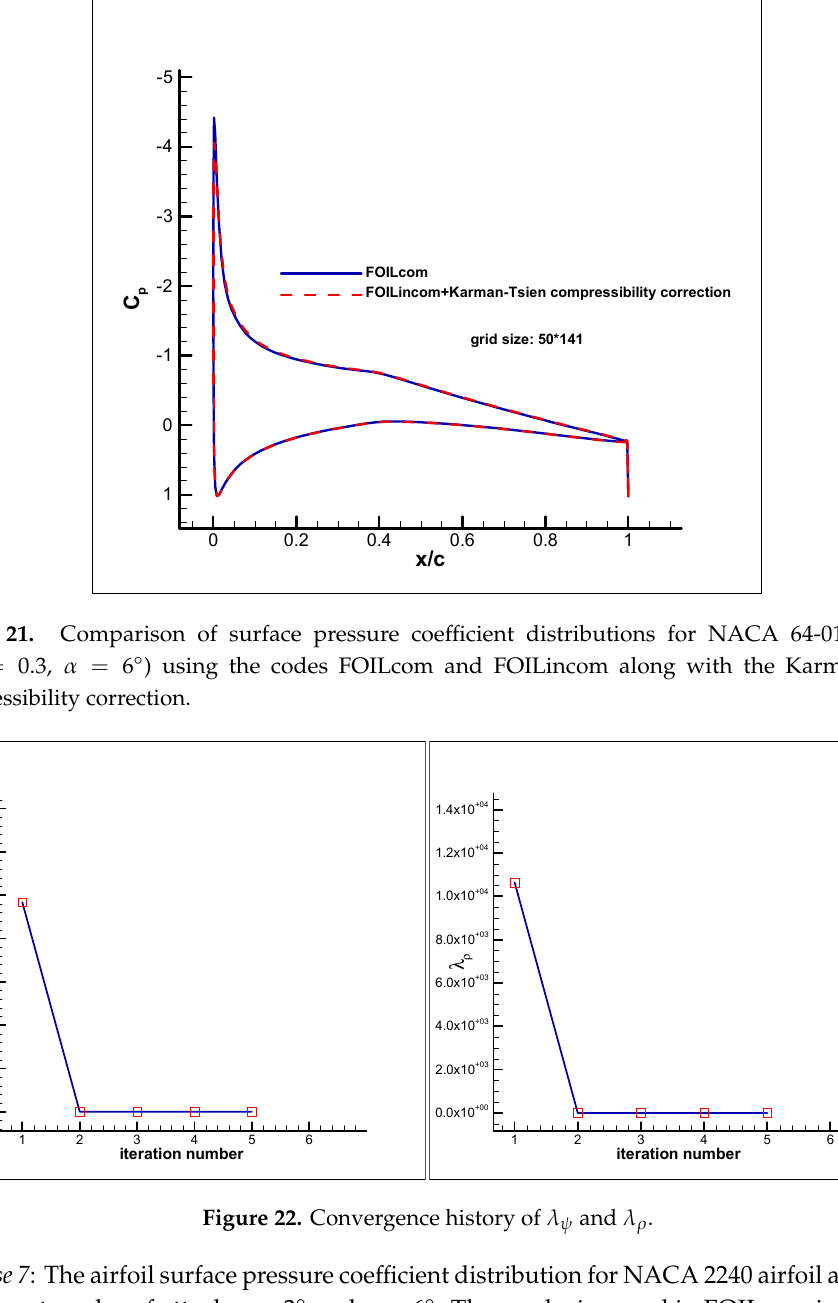
Figure 22. Convergence history of